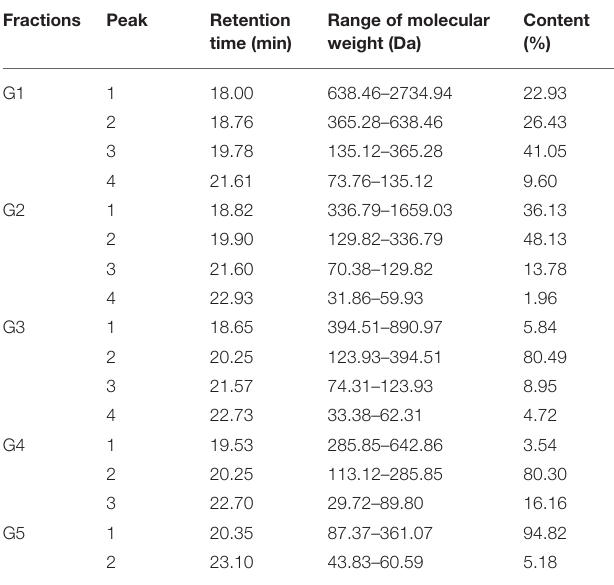
TABLE 4 | Molecular weight of fractions of ultrafiltration germinated soybean protein hydrolysates. Fractions Peak Retention Range of molecular time (min) weight